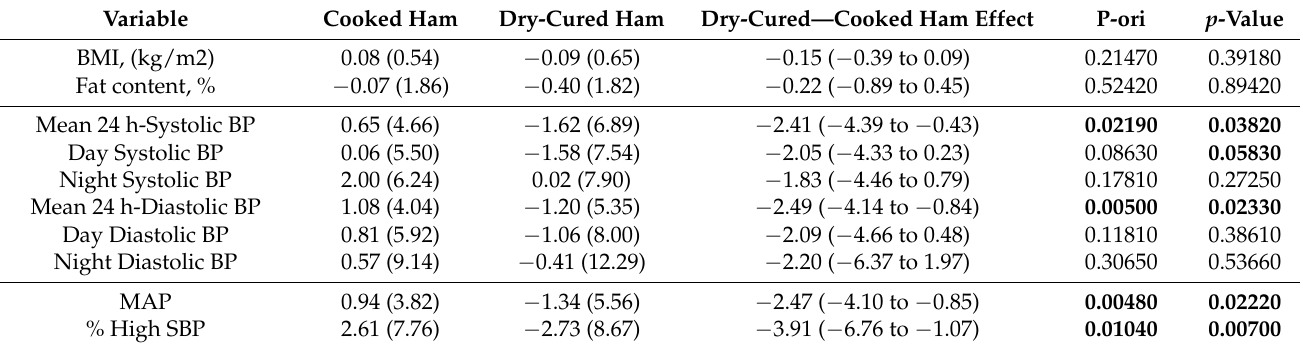
Table 4. Modelled difference of the changes in blood pressure parameters when eating dry-cured ham minus when eating placebo-control